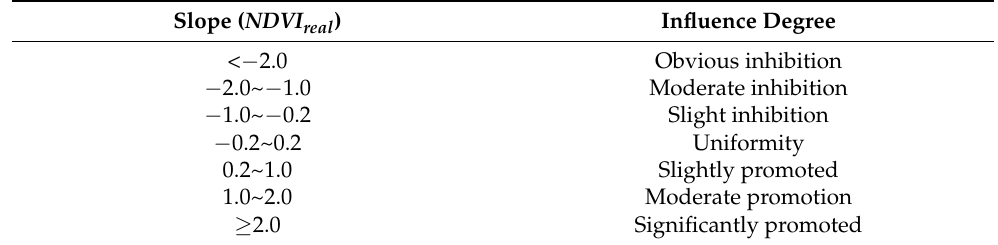
Table 1. Classification of influence of climate change and human activities on vegetation cover